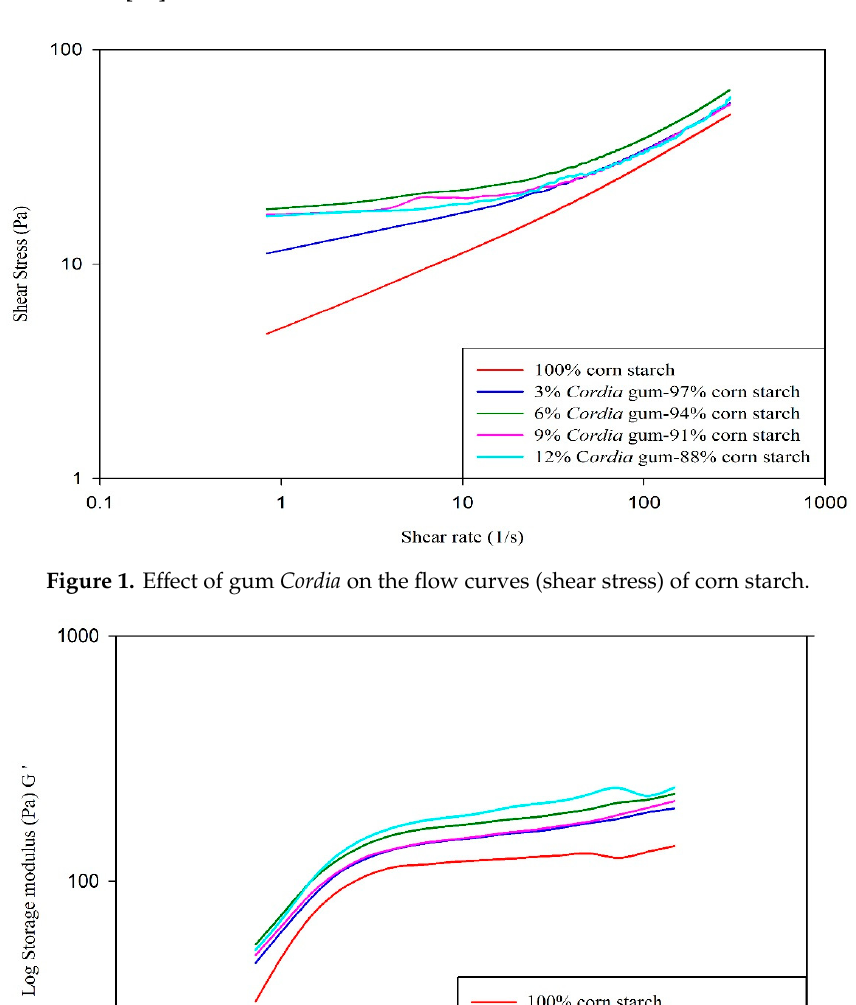
Figure 3. Effect of gum Cordia on the loss modulus (G ″ ) of corn starch gels.